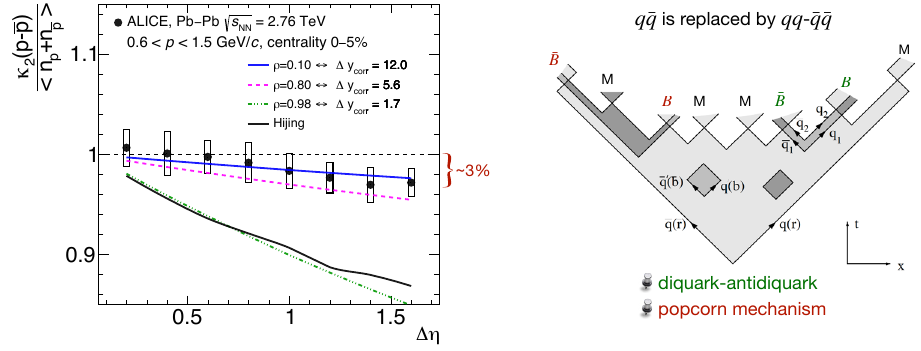
Figure 2. Left panel: scaled second order cumulants of net-proton distributions as a function of the acceptance coverage around mid-rapidity, measured by the ALICE experiment (black symbols) [32, 33]. The colored lines correspond to calculations accounting for baryon number conservation for di ff erent values of the correlation coe ffi cient in the rapidity space [18, 34]. The solid black line represents the results from the HIJING event generator. Right panel: a schematic illustration of baryon production mechanisms via the Lund string